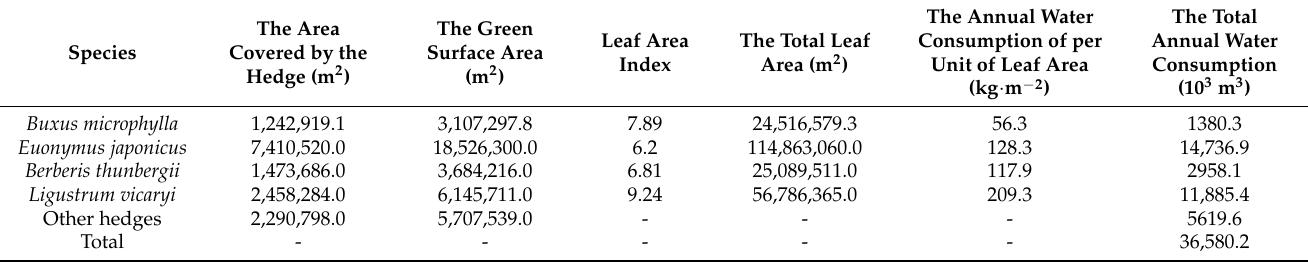
Table 11. Annual water consumption of hedges in